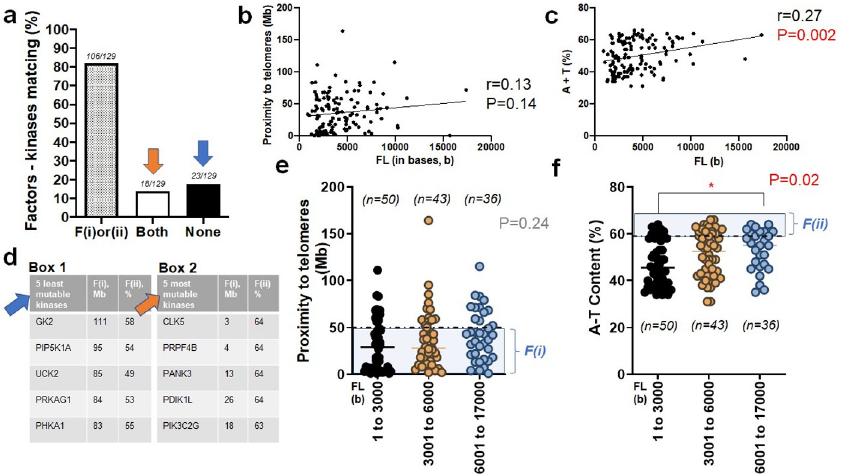
Fig 2. Prioritization of druggable kinases per the relative mutability. (a) Bar graph demonstrating the matching rate of genes encoding 129 kinases with two factors of telomere proximity, F(i), and nucleotide composition, F(ii). Genes sorted into three groups: those satisfying one of the two factors (F(i)or(ii)), those meeting F(i) and F(ii) (Both), and those satisfying neither F(i) nor F(ii) (None, blue arrow) (b) Scatter plot exhibiting the Pearson correlation between the full length of genes encoding 129 kinases and their proximity to telomeres. Pearson correlation coefficient at r = 0.13 with the level of statistical significance at P = 0.14. (c) Scatter plot showing the Pearson correlation between the full length of genes encoding 129 kinases and A+T content. Pearson correlation coefficient at r = 0.27 with the level of statistical significance at P = 0.002. (d) Five candidate genes (GK2, PIP5K1A, UCK2, PRKAG1, PHKA1) sorted per the relatively lower mutability (the ‘None’ group; Box 1); five alternative candidates (CKL5, PRPF4B, PANK3, PDIK1L, PIK3C2G) sorted per the relatively higher mutability (the ‘Both’ group; Box 2). (e) Scatter plot showing proximity to telomeres of genes encoding 129 kinases with respect to three sub-groups of the gene full-length size (unit: base or b). A horizontal dotted line indicates 50 Mb. No differences among three groups found at P = 0.24 after one-way ANOVA (f) Scatter plot summarizing A+T content of genes encoding 129 kinases with respect to the gene size in base or b. A horizontal dotted line indicates 59%. A significant difference between the shortest (1 to 3000 b) and longest size group (6001 to 17000 b) found at P = 0.02. F(i) and F(ii) indicate the first and second factor, respectively (e and f). * , P < 0.05.